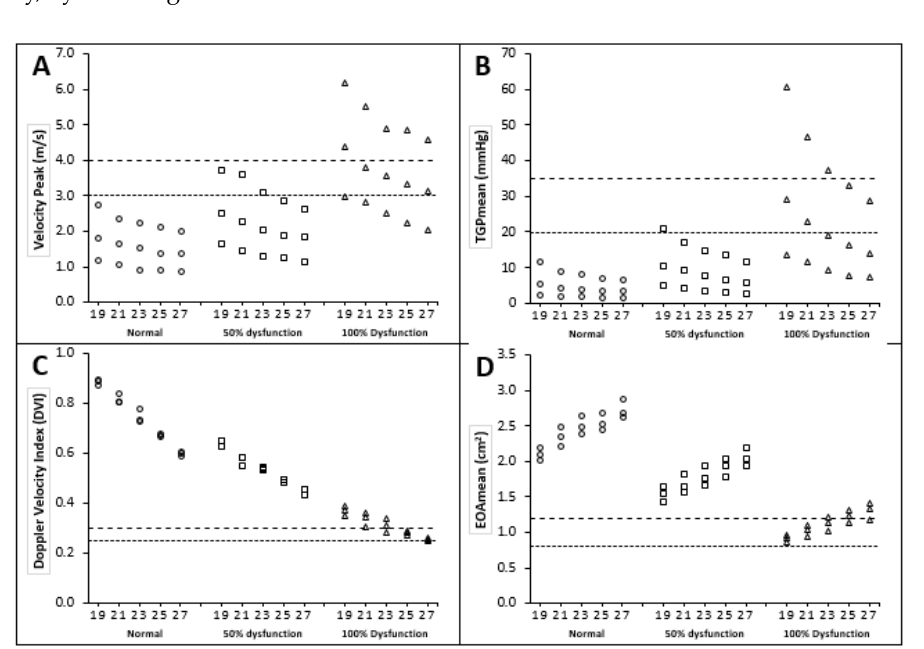
Figure 9. The Doppler echocardiographic parameters calculated for the (0, 50, 100%) of valve dysfunction with the presence of different sub valvar stenosis at three flow rates. ( A ) Peak velocity; ( B ) mean transvalvular pressure gradient; ( C ) Doppler velocity index (DVI); and ( D ) effective orifice area (EOA). The dashed and dotted lines represent the lower and upper proposed cut-off values in the ASE guidelines, respectively.